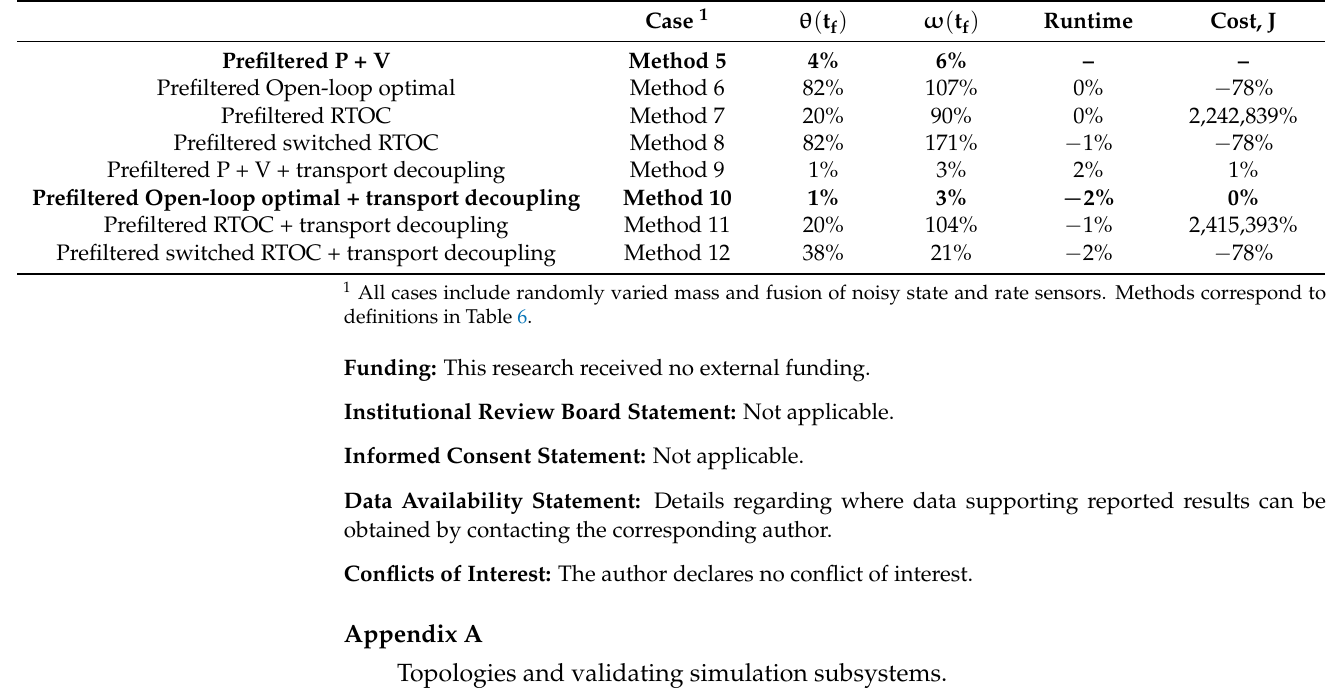
Table 8. Performance comparison: instrument attitude and rates indicate error percentages, while runtime and cost displays are percent performance improvements over comparative benchmark cases 2 and 5, respectively. Methods 1–4 are compared to idealized method 2 (lacking transport theorem); while cases 6–12 are compared to method 10 realistic cases with transport theorem 1